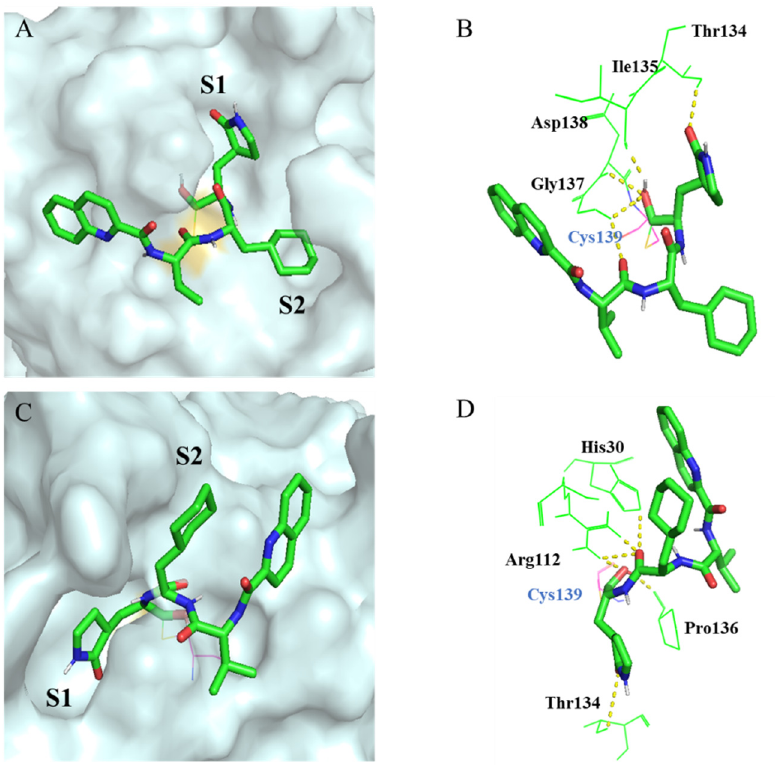
Figure 7. Molecular docking of compound 10d in the GI.1 and GII.4 norovirus 3CL protease. ( A ) The binding mode of 10d at the substrate-binding site of the GI.1 norovirus 3CL pro (PDB code: 3UR9). The GI.1 norovirus 3CL pro was shown as molecular surface and 10d was shown by green sticks. ( B ) Interactions of 10d with the surrounding residues. Residues are shown as light green lines, and H- bonds are represented by yellow dashed lines. ( C ) The binding mode of 10d at the substrate-binding site of the GII.4 norovirus 3CL pro (PDB code: 6NIR). ( D ) Interactions of 10d with the surrounding residues. The Schrödinger program (Maestro covalent docking) was used for calculations and PyMOL program for visualizations.